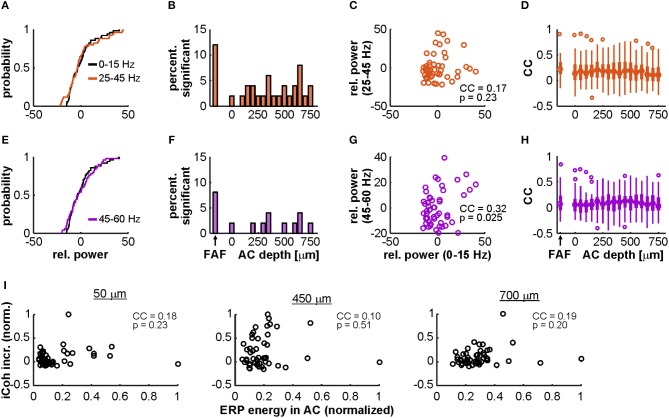
Power distributions of gamma-band and low-frequency LFPs in AC and FAF. (A) Distributions of the relative power of low-frequency (0–15 Hz; black) and gamma-band activity (25–45 Hz; orange) across trials, recorded from a single representative penetration in the FAF. These distributions were not significantly different from each other (2-sample Kolmogorov-Smirnov test, p = 0.84). (B) Percentage from the total number of penetrations (n = 50) for which the distributions of low-frequency and gamma (25–45 Hz) power were significantly different from each other at an alpha of 0.01, in FAF and at different depths of the AC. (C) Scatter plot and correlation coefficient (CC) of the trial-by-trial relationship between low-frequency and gamma band (25–45 Hz) power (n = 50 trials), for the same representative penetration shown in (A). The CC was of 0.17, and it was not significant: p = 0.23. (D) Distribution, in FAF and at all AC depths, of CCs between gamma-band (25–45 Hz) and low-frequency power. The median in the AC across depths was of 0.17, whereas the median in the FAF was of 0.22. (E–H) Similar to (A–D), but the gamma range considered was of 45–60 Hz (signaled in purple). In (E), both distributions were also not significant from each other (two-sample Kolmogorov-Smirnov test, p = 0.84). The CC in (G) was of 0.32, and it was not significant at an alpha of 0.01 (p = 0.025). In (H), the median across depths in the AC was of 0.08, whereas the median CC in the FAF was of 0.07. (I) Correlations between evoked-potential (ERP) energy in AC and gamma-band coherence increase (same as in Figure 5) for three representative depths in the AC (at 50, 450, and 700 μm; all depths are shown in Figure S3). Values are normalized for clarity. There were no significant correlations at any of the depths shown (p ≥ 0.2).